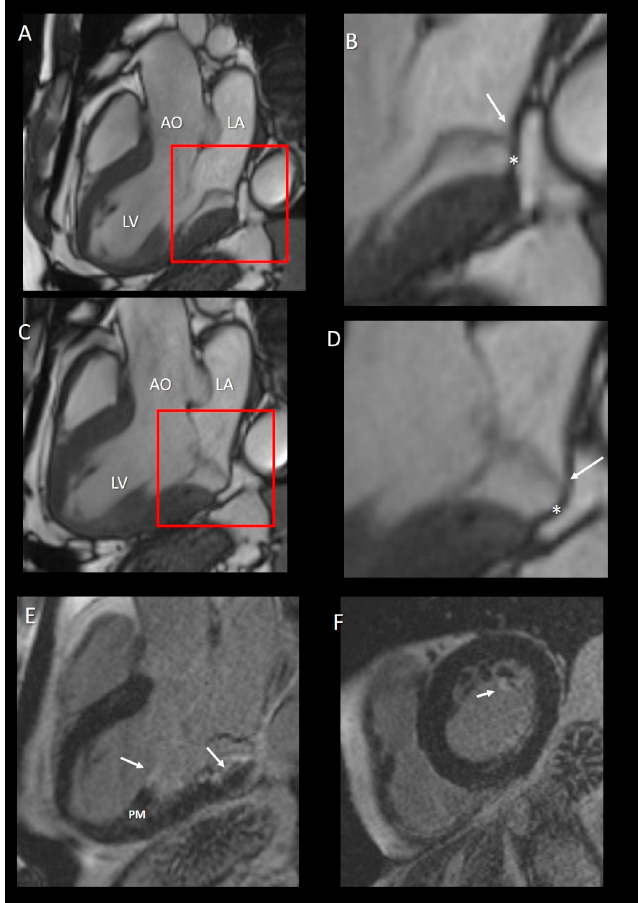
Figure 10. ( A , C ) CMR images in long-axis view in diastole ( A ) and in systole ( C ). ( B , D ) Magnified images of the structures in the red squares in panel A and C, respectively. The insertion of posterior leaflets on the atrial myocardium (arrow) is well visible either in diastole (panel B ) or in systole (panel C ). The asterisks in both B and D panel mark the curtain-like fibrous tissue. ( E ) Long-axis view late gadolinium enhancement (LGE) showing the fibrosis on the tip of papillary muscle (PM) and at the base of LV (arrows). ( F ) Short-axis view LGE showing the fibrosis on the tip of PM.